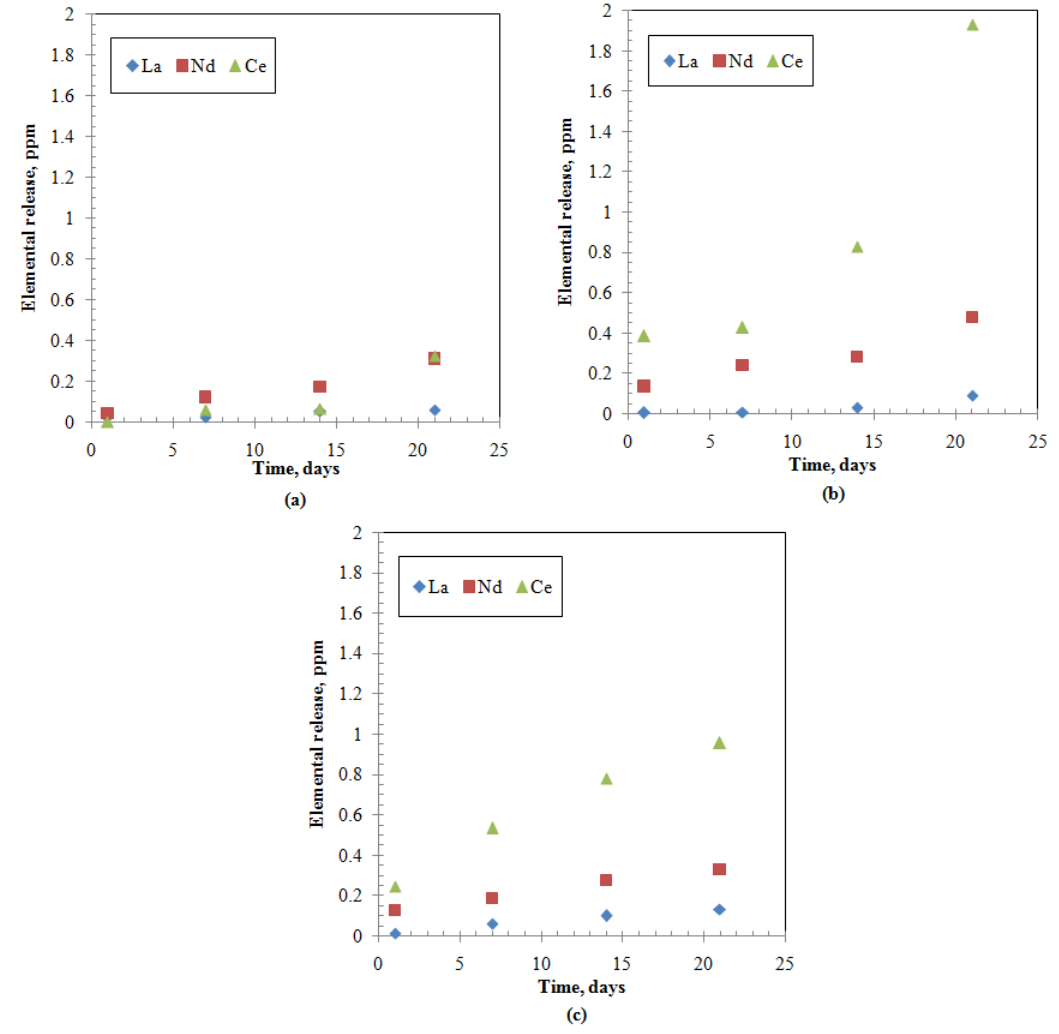
Figure 3. Rare earth elements releases from the studied samples: ( a ) ABS-Waste (17); ( b ) MABS-Waste (20); ( c ) ABS-Waste (25). Table 5. The normalized release rate (mg · m − 2 · d − 1 ) for structural elements and modifiers.